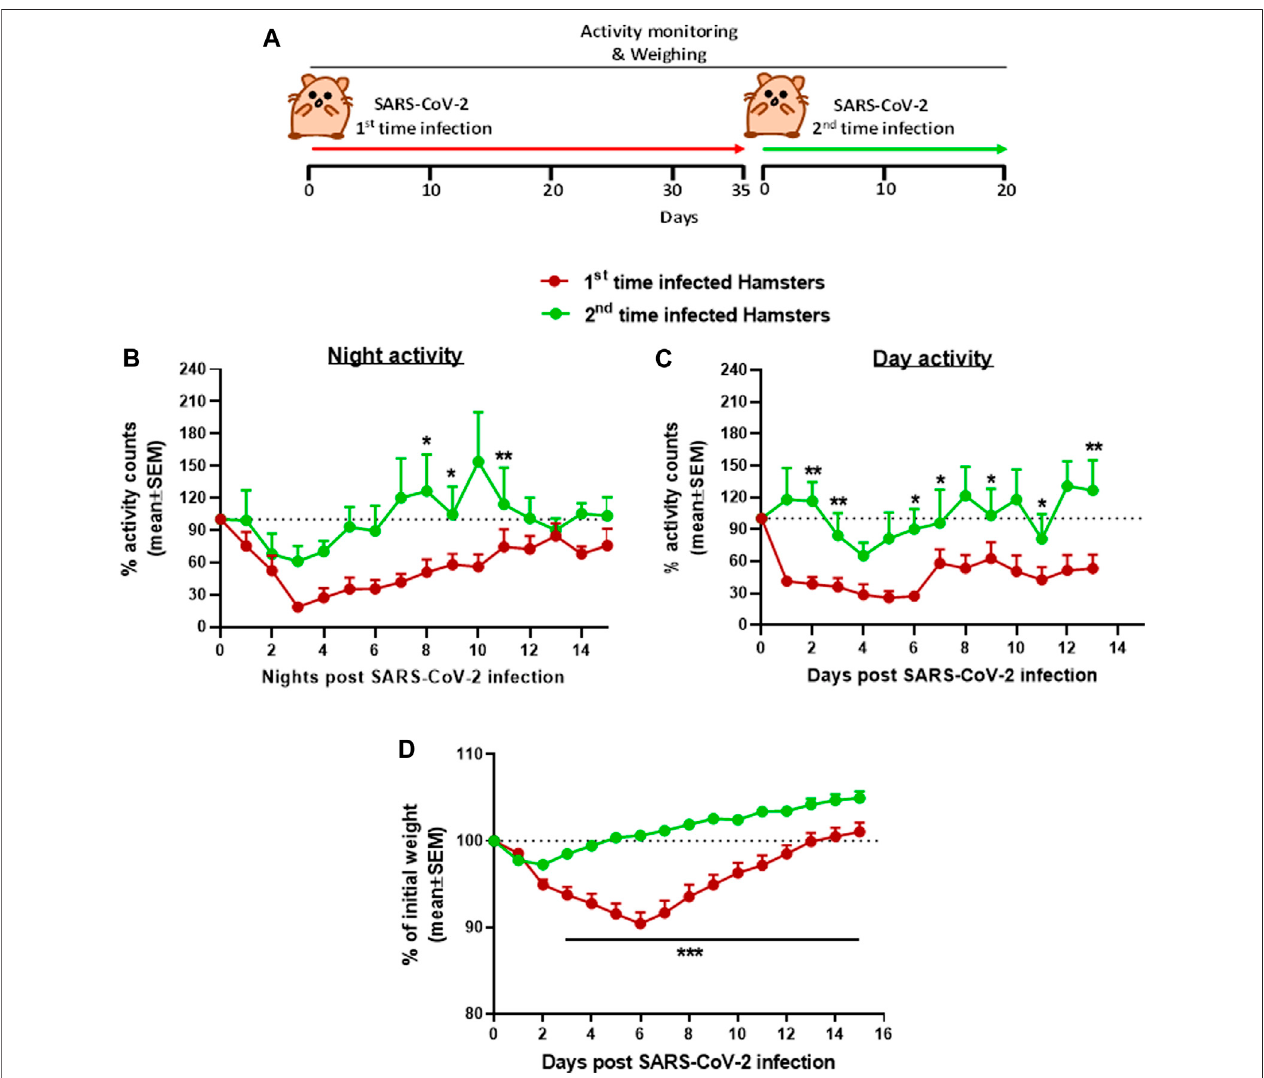
FIGURE 4 | Group activity and body weight changes in male hamsters reinfected with SARS-CoV-2 after recovery. (A) Experiment outline: SARS-CoV-2 i.n. infection (5 × 10 6 pfu/hamster) 35 days after the fi rst infection withthe same dose. Percent oftotalactivity countsduring nighttime(5 pm – 5am, B ),daytime (5 am – 5pm, C ),andweightchanges (D) over20 dayscomparedto fi rsttimeinfected.n (cid:2) 4samecagesof fi rsttimeandreinfected hamsters,4hamsters/cage.* p < 0.05,** p < 0.01, and *** p <